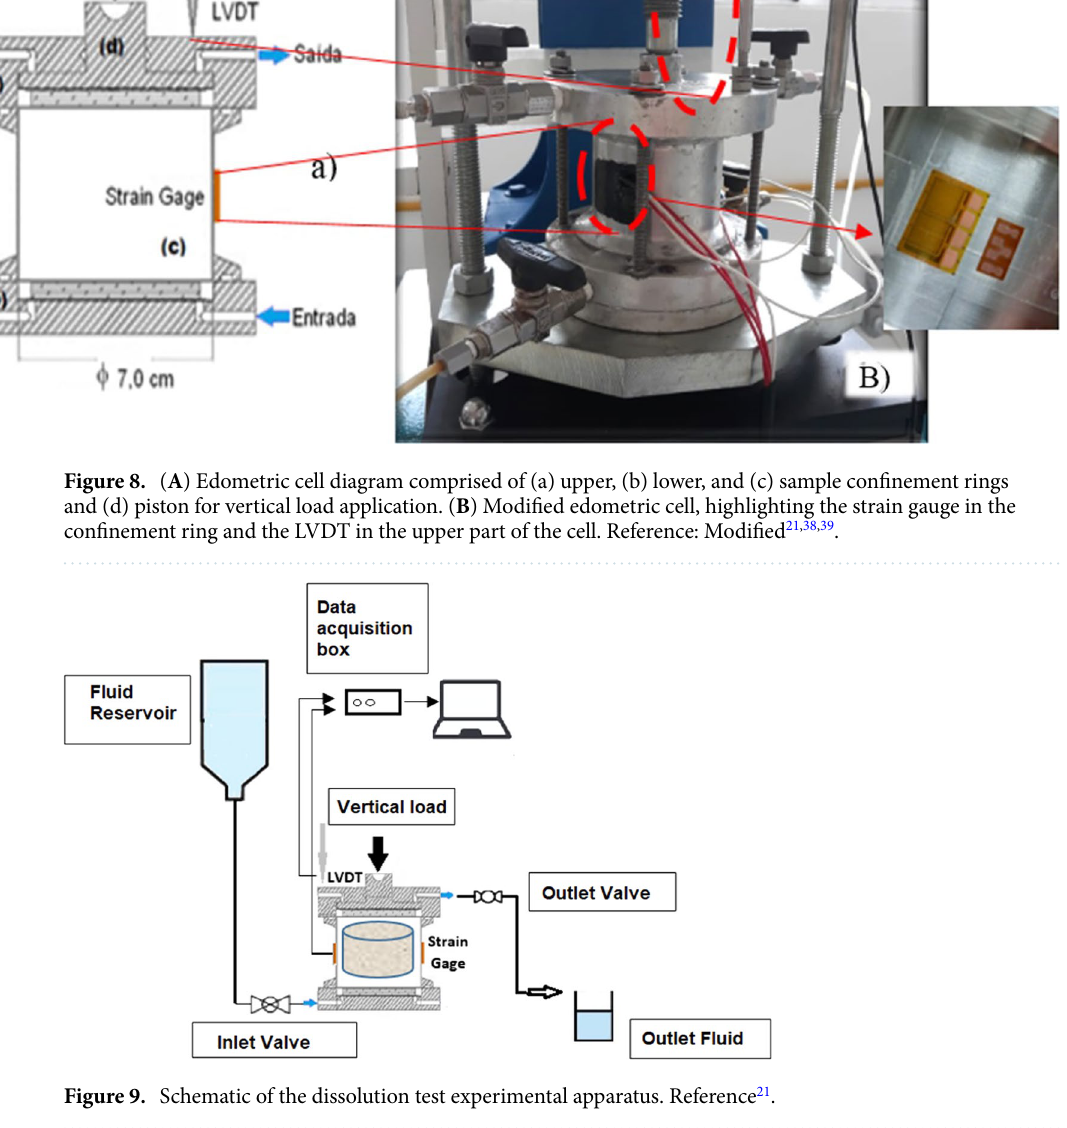
Figure 9. Schematic of the dissolution test experimental apparatus. Reference 21